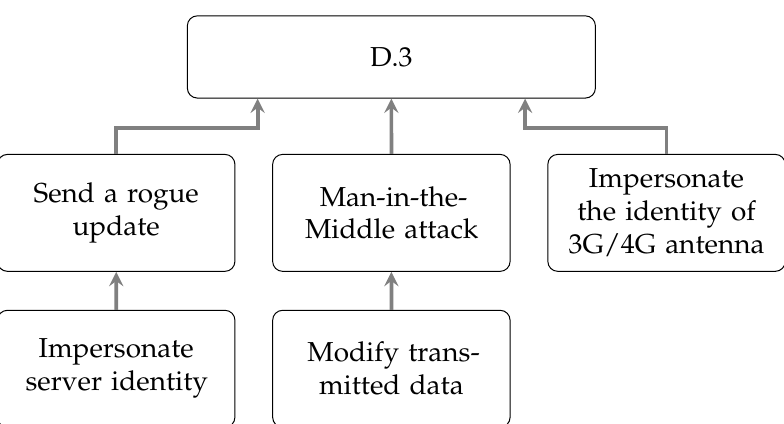
Figure 4. Attack tree showing three attack paths, each from lowest child to root. Table 3. Sample attack path scenarios for damage scenario where attacker modifies transmitted